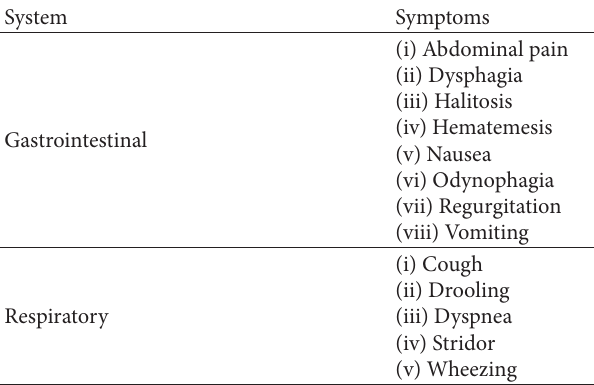
Table 1: Clinical manifestation of foreign body